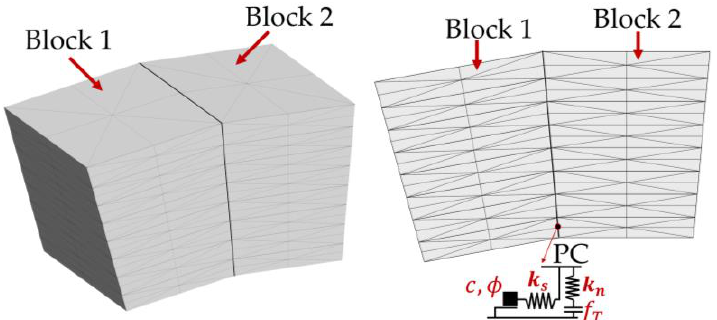
Figure 2. Representation of point contact (PC) in 2D defined between two blocks ( 𝑐 and 𝑓 𝑇 are taken as zero to obtain dry-joint contact